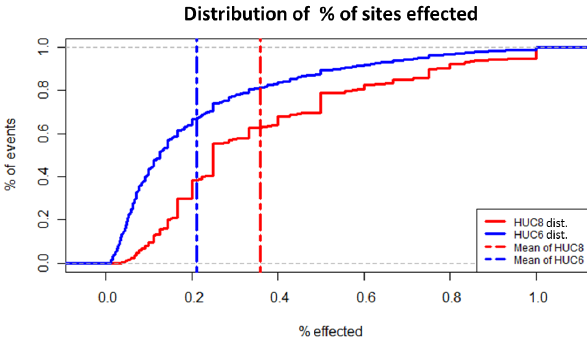
Figure 5. CDF of the percentage of sites impacted during each event within our catalog. Mean % of the entire distribution is noted and split by